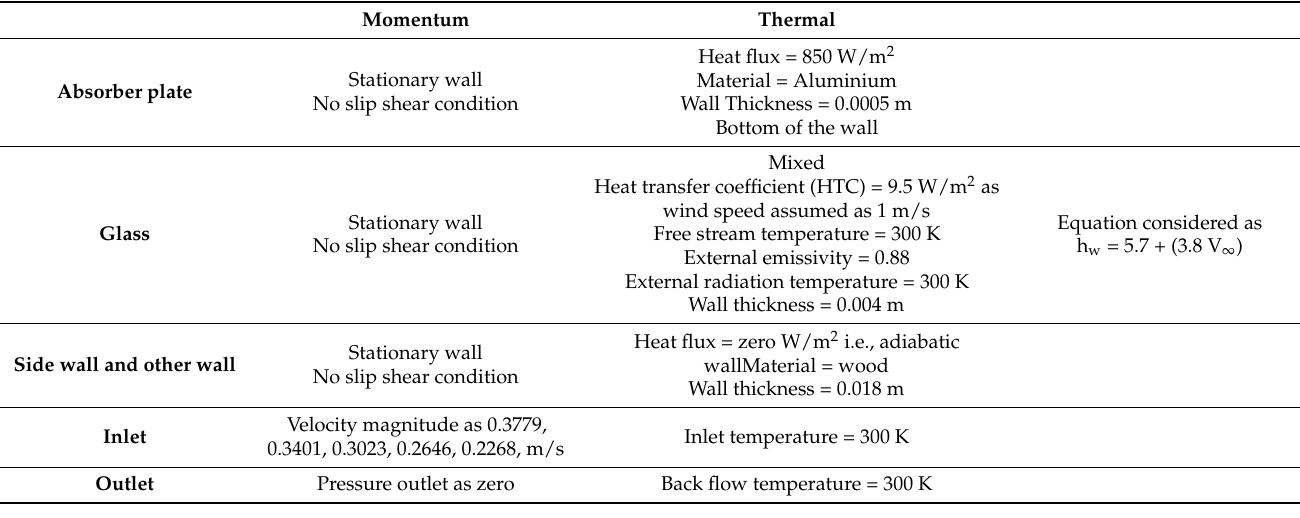
Table 3. Boundary conditions used during simulation in SAH [2,13,14,17,37].